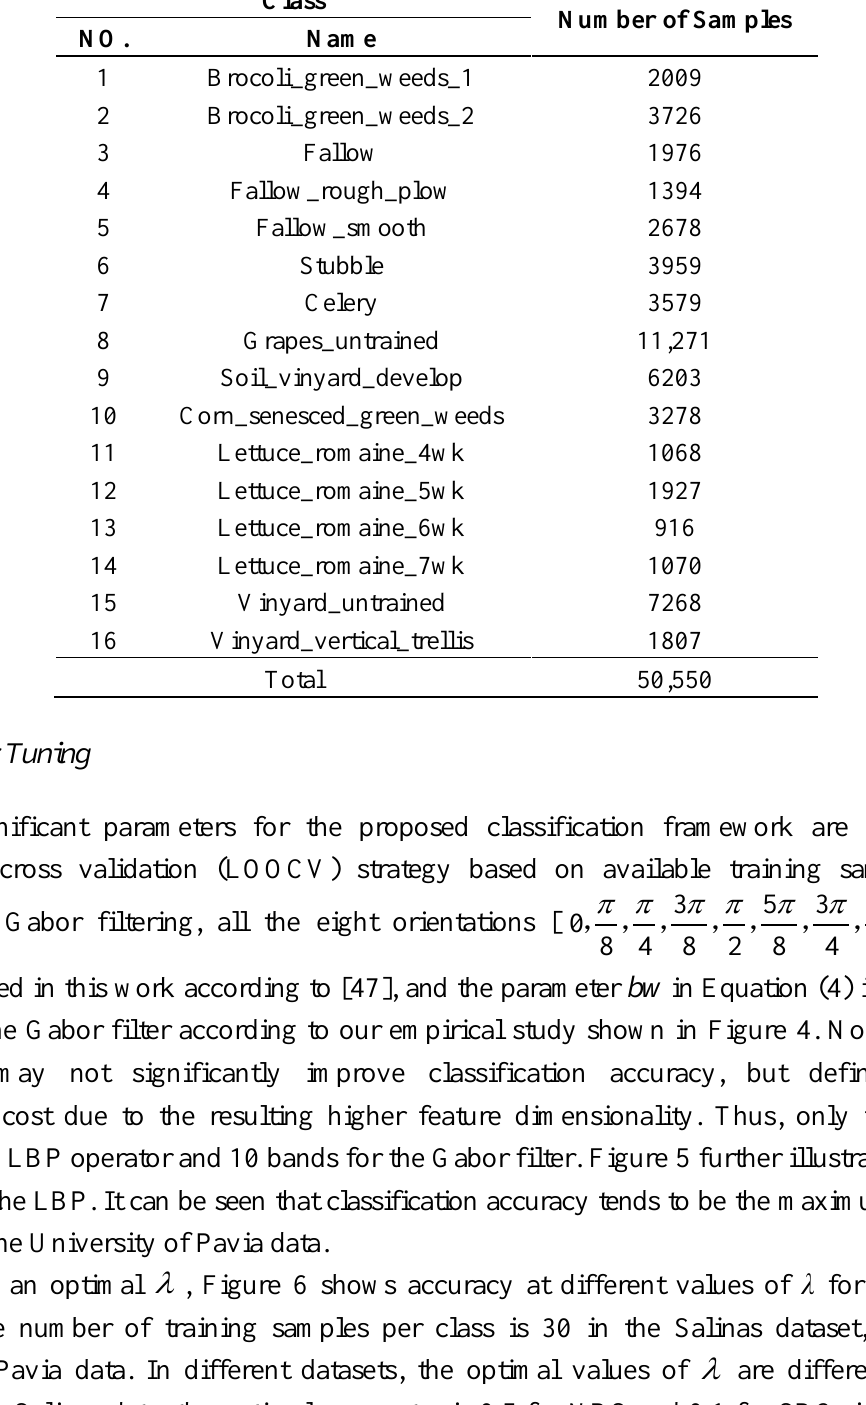
Number of Samples